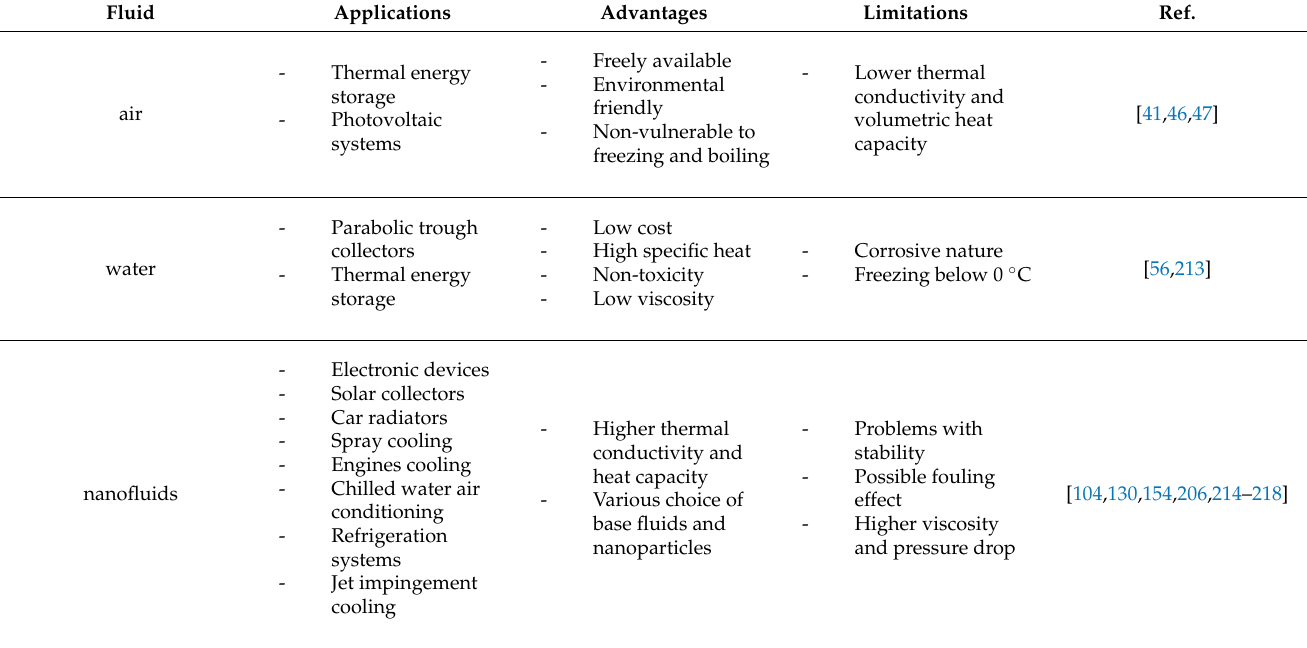
Table 3. Examples of various heat and coolant transfer fluids